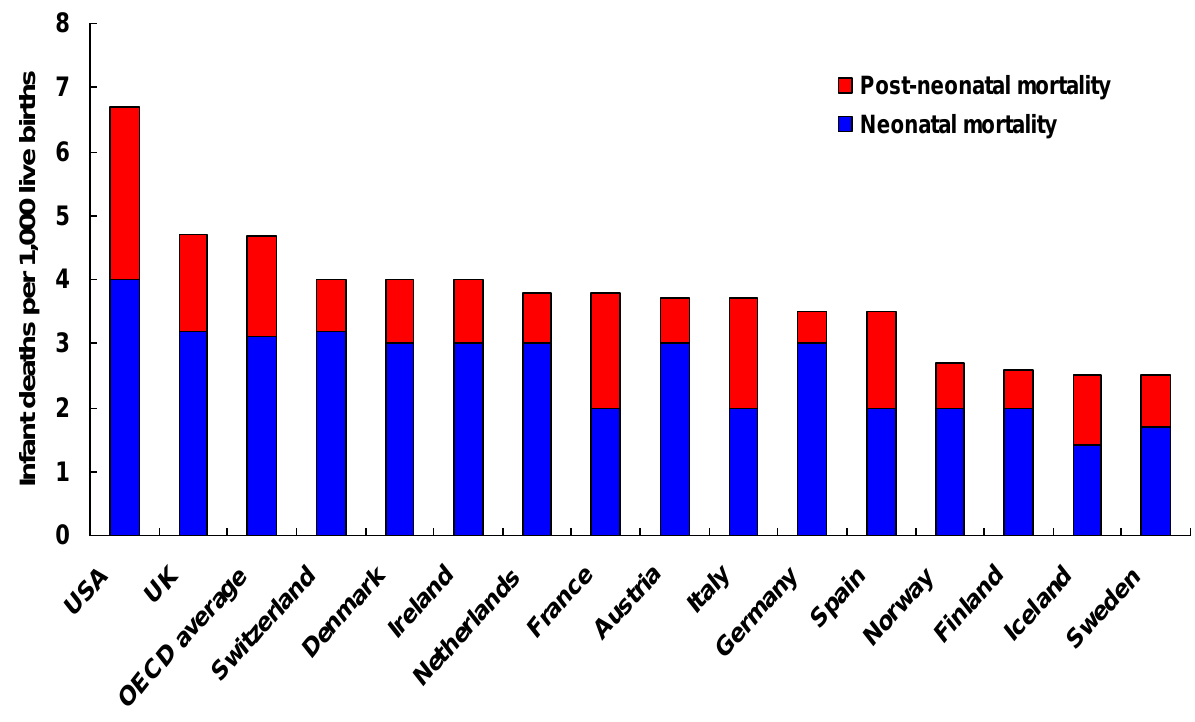
Figure 1. Infant mortality rates (number of infant deaths per 1,000 live births) in 2008 in selected OECD member countries. Source : OECD Health Data 2010 (April 2011 version) and WHO Global Health Observatory